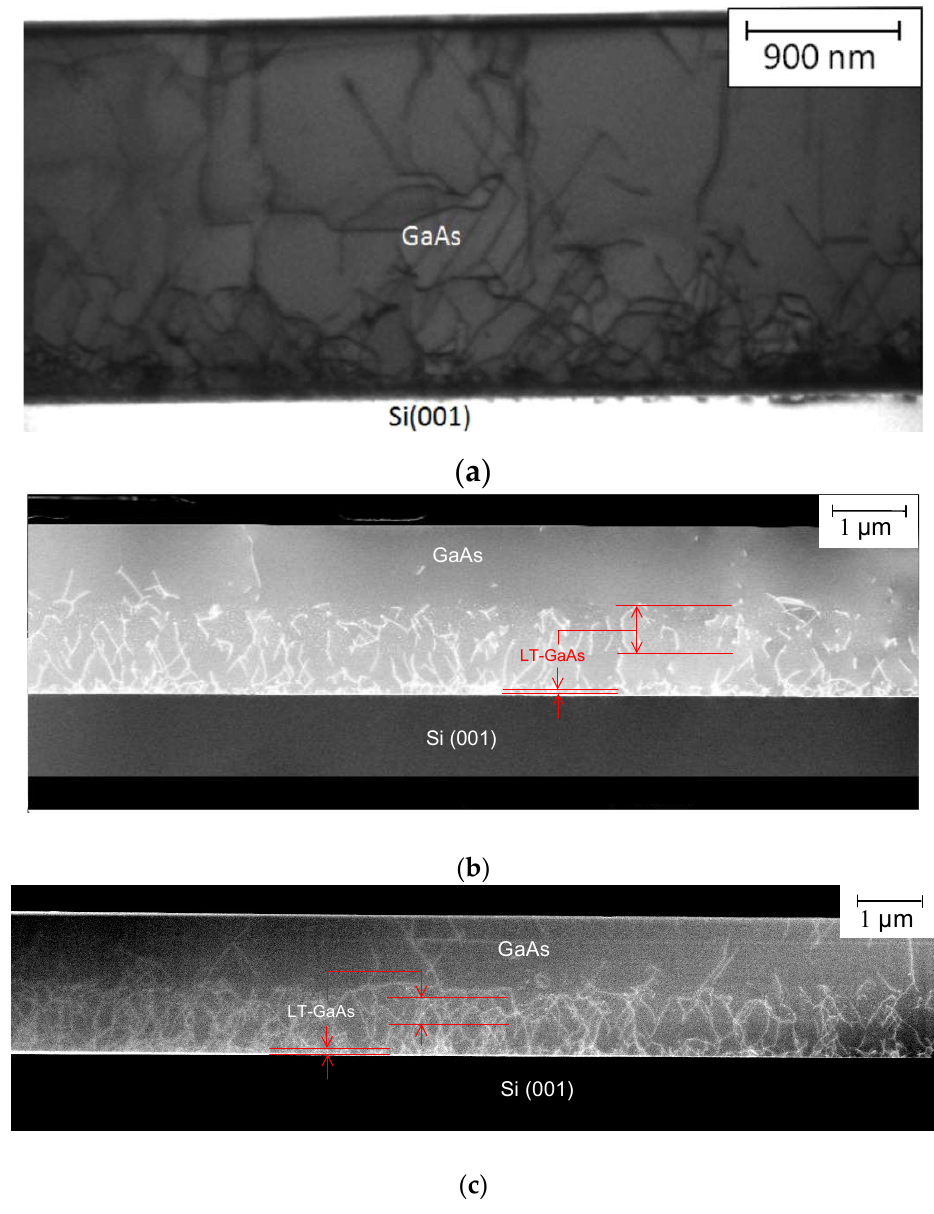
Figure 3. TEM images of the cross sections of I-a ( a ), II-a ( b ) and II-a2 ( c ) GaAs/Si HSs, respectively. The LT-GaAs layer positions are indicated with red arrows.